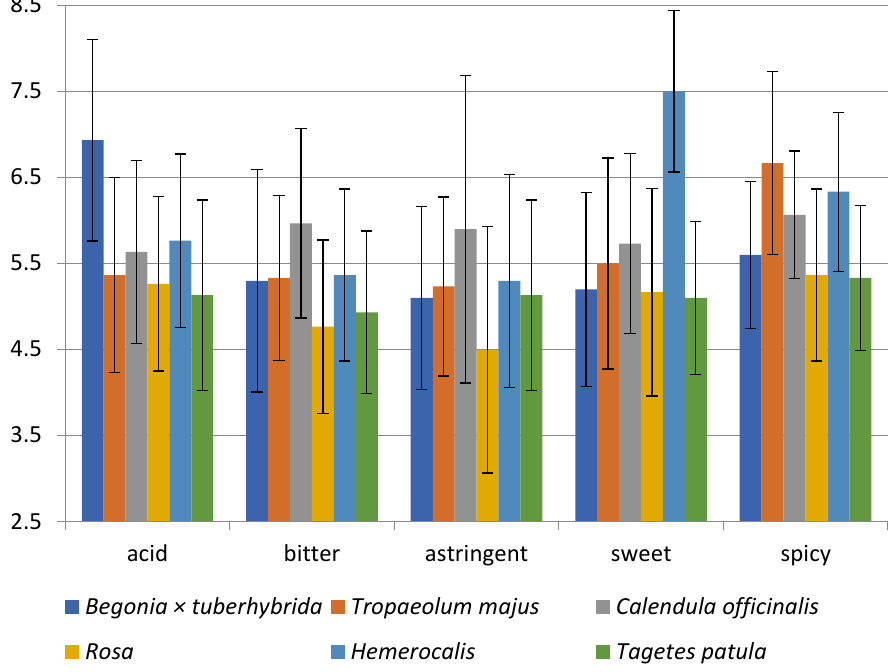
Figure 2. Sensory analysis diagram for the taste of 6 edible flowers; Begonia × tuberhybrida ; T. majus ; C. officinalis ; Rosa ; Hemerocallis ; T. patula . The scale of taste intensity ranged from very strong, maximum (=1) through slightly moderate (=5) to without taste (=9).